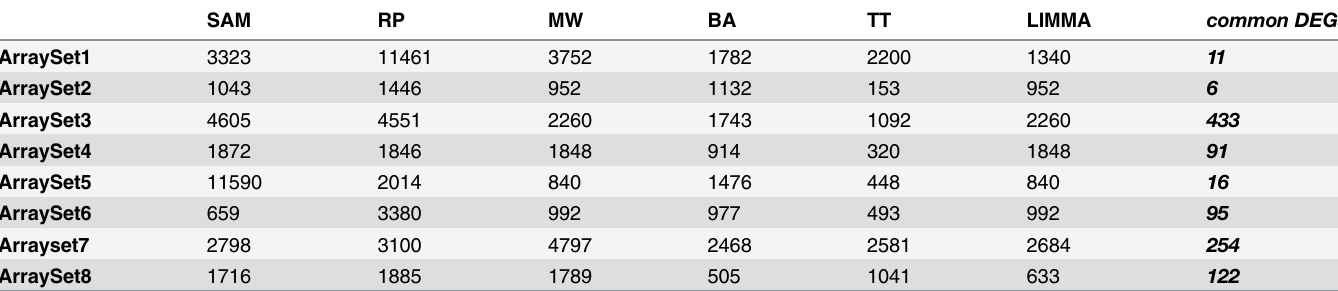
Table 4. DEGs detected in Arraysets by different methods (22,283 in all).